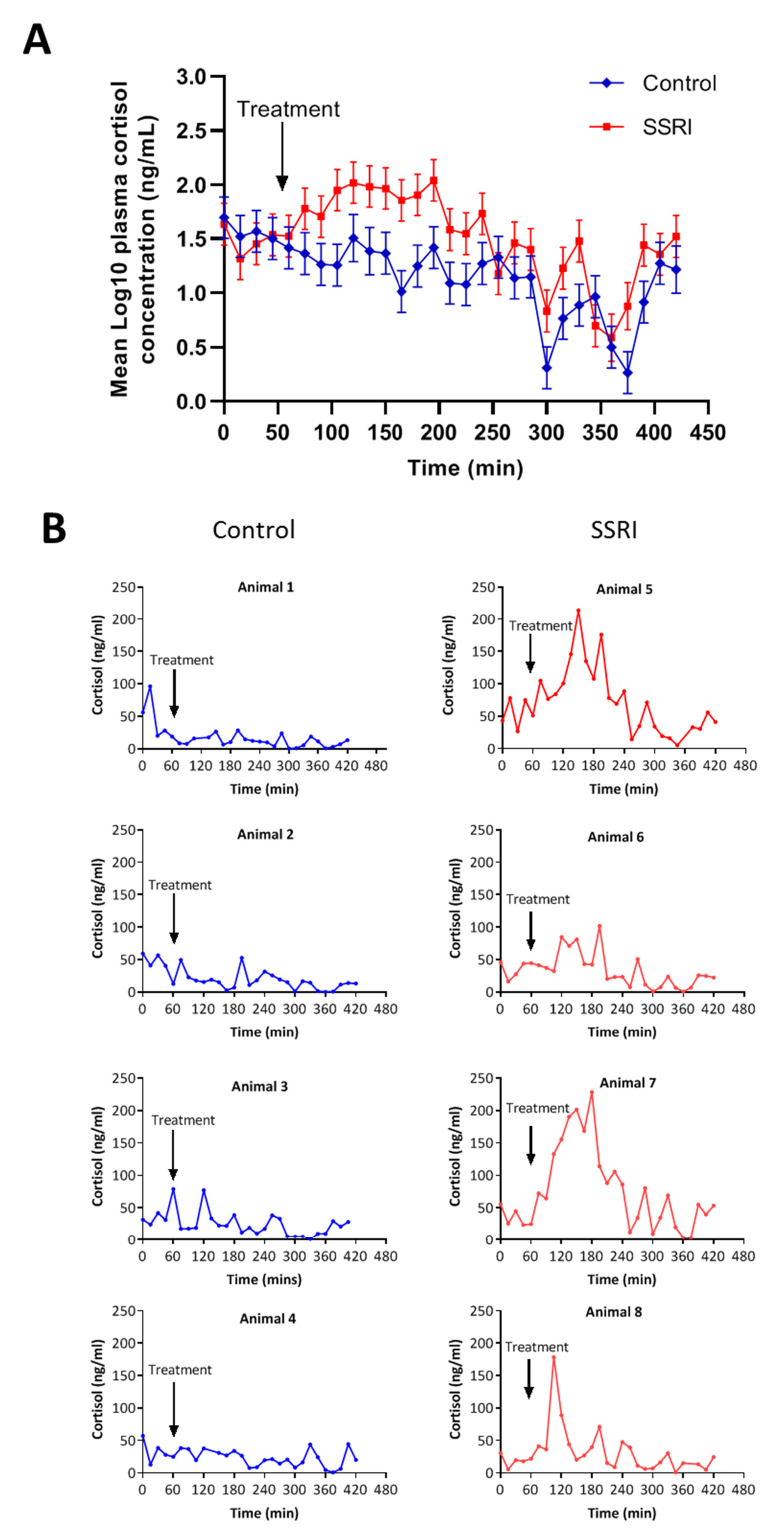
Figure 1. Plasma cortisol concentrations of pigs treated with either a single intravenous dose of the selective serotonin reuptake inhibitor (SSRI) fluoxetine hydrochloride (100 mg suspended in 10 mL saline) or saline control (10 mL). ( A ) Mean Log10 plasma cortisol concentration (ng / mL) ± SEM of animals with SSRI treatment in comparison to control animals that received saline. ( B ) Individual cortisol response profiles of control (animals 1–4) and SSRI treated (animals 5–8)